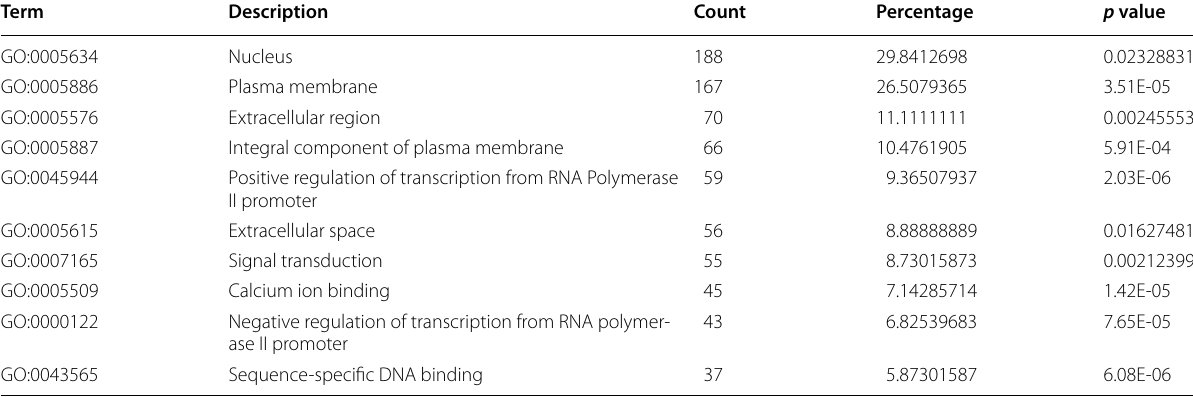
Table 3 Top 10 significantly enrichment analysis of hypo-methylated DMGs in periodontitis